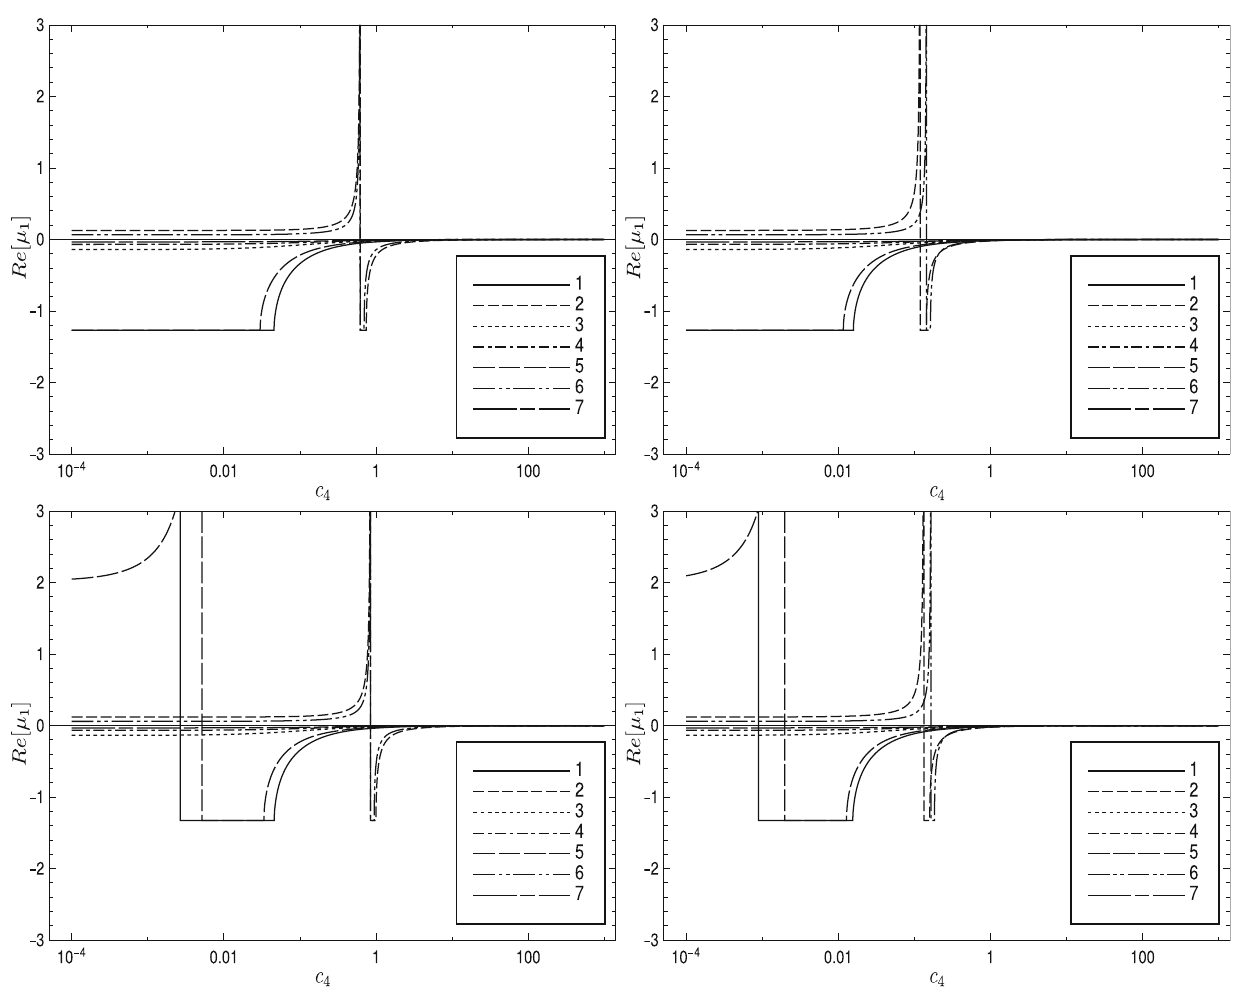
Fig. 1 Plots of the real part of μ 1 as a function of c 4 . The upper left, upper right, lower left and lower right panels correspond to ( x λ , n ) = ( 0 . 92 , − 1 ),( 0 . 92 , − 2 ),( 0 . 69 , − 1 ) and ( 0 . 69 , − 2 ) , respec- 4